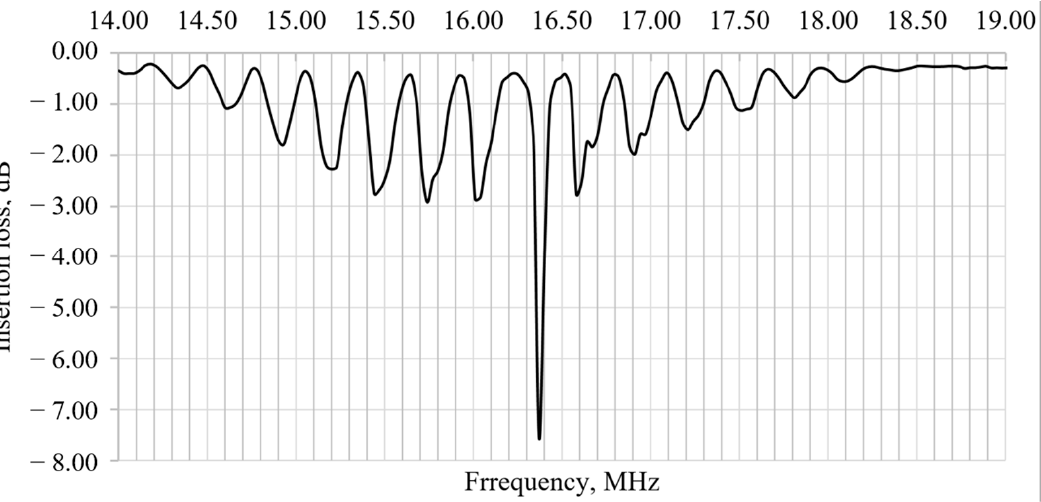
Figure 6. Spectrum of the primary channel of the sensitive element of a solid-state gyroscope. As one can see from this image, the resonance peak occurs at 16.37 MHz, while the predicted frequency was 16.49 MHz. Thus, the difference between the real frequency and the calculated one is less than 1%, which indicates a high quality of performance. Also, the ratio of the central peak to the nearest harmonics is 2.68. The obtained frequency response indicates that the manufactured sensitive element can be included in the positive feedback circuit of the amplifier and, on this basis, directly form a solid-state gyroscope based on